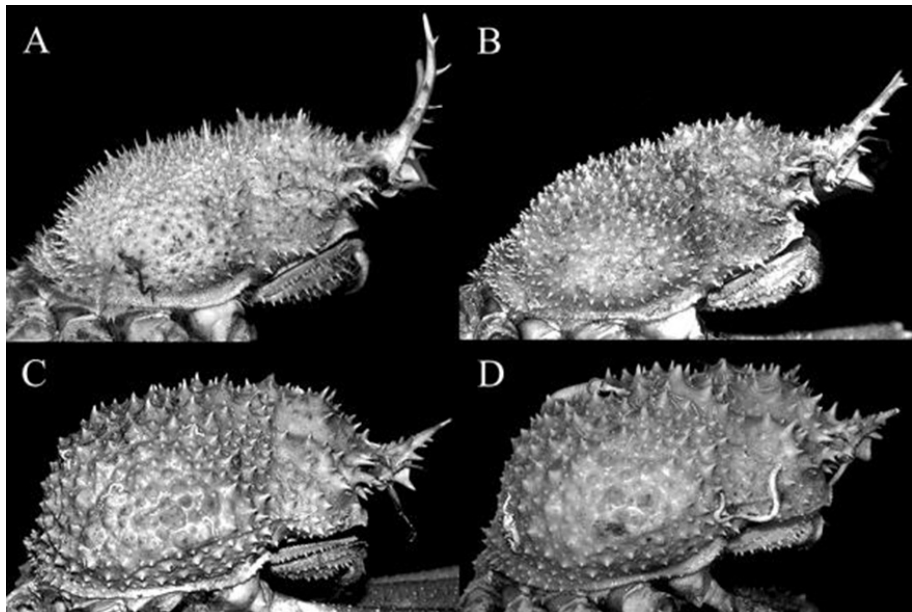
Figure 5. A Pleistacantha moseleyi (Miers, 1885), male (cl 82.5 mm, cw 61.6 mm) (ZRC 2005.117), Philippines B Pleistacantha pungens (Wood-Mason, in Wood-Mason & Alcock, 1891), male (cl 94.0 mm, cw 67.6 mm) (ZRC 2016.23), Myanmar C Pleistacantha kannu sp. n., holotype male (cl 106.2 mm, cw 87.0 mm) (CASAU), India D Pleistacantha kannu sp. n., paratype ovigerous female (cl 91.3 mm, cw 75.5 mm) (DABFUK),